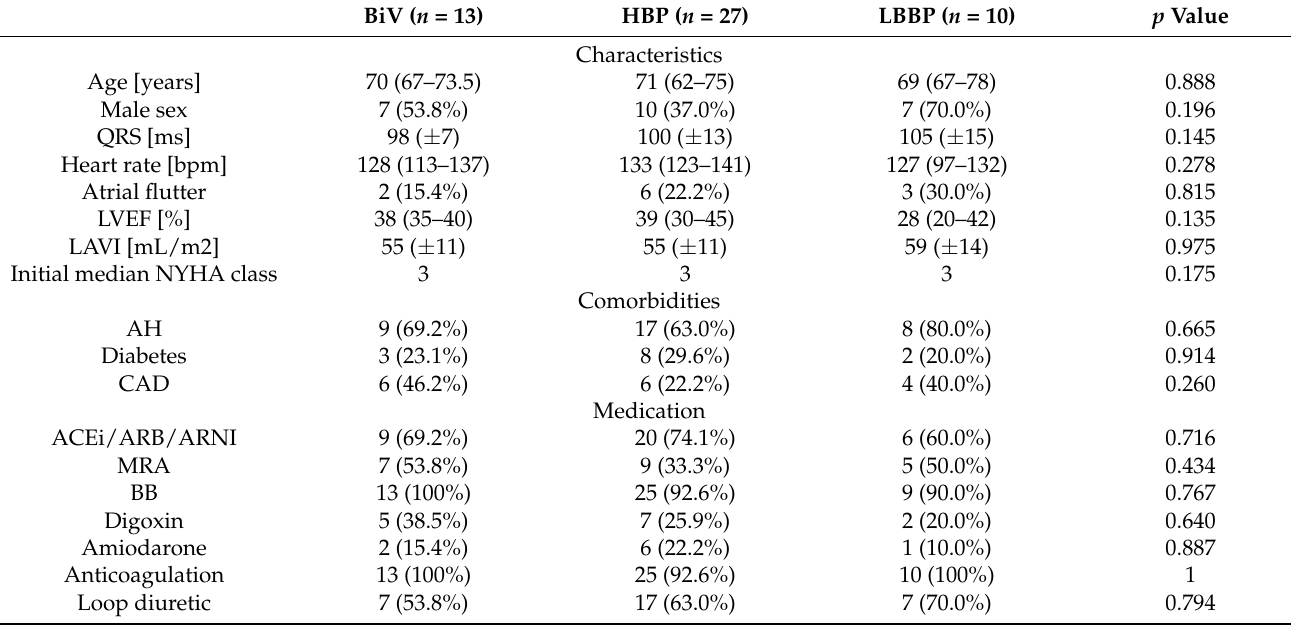
Table 1. Baseline characteristics of patients by pacing